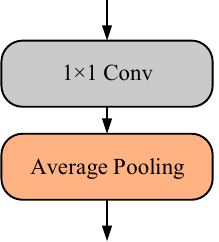
Figure 3. Structure of multiscale pooling block.